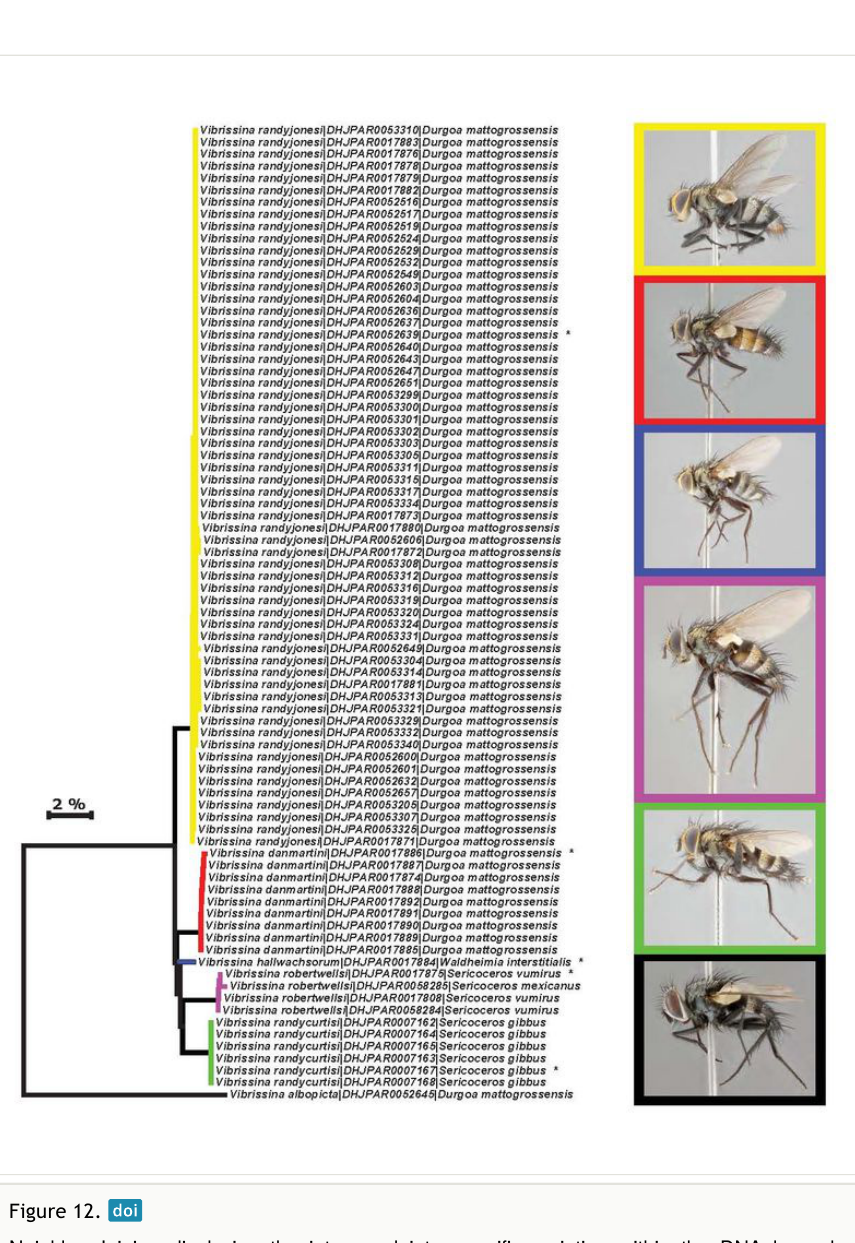
Neighbor-Joining displaying the inter- and intra-speci fi c variation within the DNA barcode region for the 6 species of Vibrissina Rondani reared from ACG. Tip labels include the species name|specimen accession number|host species; the holotype of each species is indicated with an asterisk. Habitus photographs in lateral view are presented for the holotypes of the new species. An ACG-reared voucher specimen is presented for V. albopicta